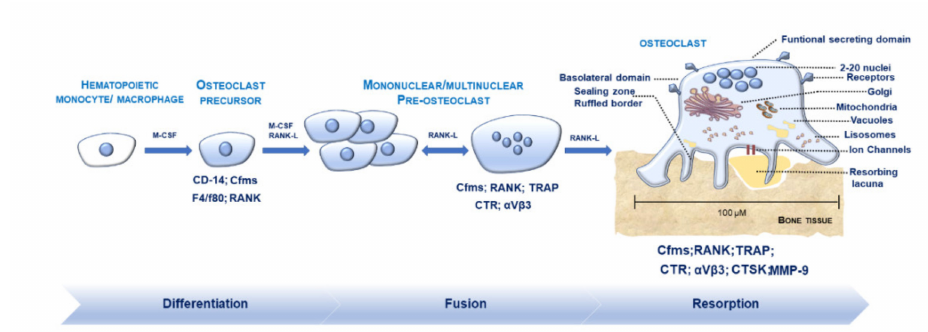
Figure 1. Osteoclasts (OCs) formation and di ff erentiation. Hematopoietic monocytes / macrophages mature into OCs precursors (pre-OCs) (positive for CD-14, Cfms, F4 / F80, RANK) after macrophage colony-stimulating factor (M-CSF) stimulation. The addition of M-CSF and receptor activator for nuclear factor κ B ligand (RANK-L) drives di ff erentiation of pre-OCs and fusion towards mature multinucleated OCs (positive for Cfms, RANK, TRAP, CTR, CTSK, MMP-9). OCs display a polarised shape and own up to 2–20 nuclei. OCs surface membrane exhibits channels (responsible for the release of ions and matrix-degrading enzymes favouring bone resorption) and four distinct domains: the sealing zone (SZ), the ru ffl ed border (RB), the basolateral domain (BD), and the functional secretory domain (FSD). Golgi apparatus, mitochondria, lysosomes, vacuoles are within the cytoplasm to support OCs